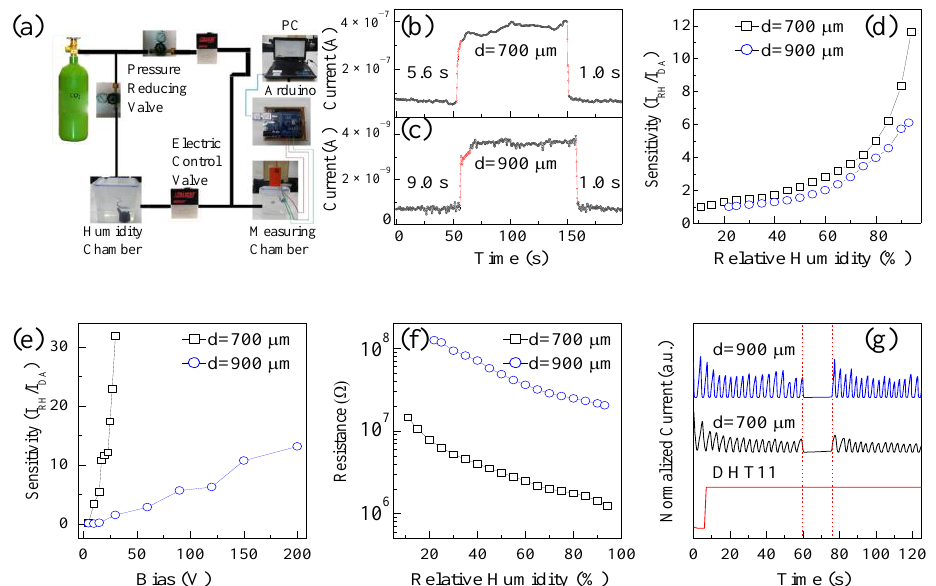
Figure 4. (Color online) ( a ) Scheme of humidity sensing system; ( b , c ) humidity response and recovery time of SnO 2 film with 700 and 900 μm electrode spacing, respectively; the bias voltage of 10 V has been applied in this test and the two humidity levels used for this test were 15% and 65%, respectively; ( d ) relativity humidity and ( e ) bias voltage-dependent sensitivity of SnO 2 film with different finger spacing; ( f ) relativity humidity dependent resistance of SnO 2 film with different finger spacing; ( g ) repeatability measurement of three sensor devices upon exposure to human